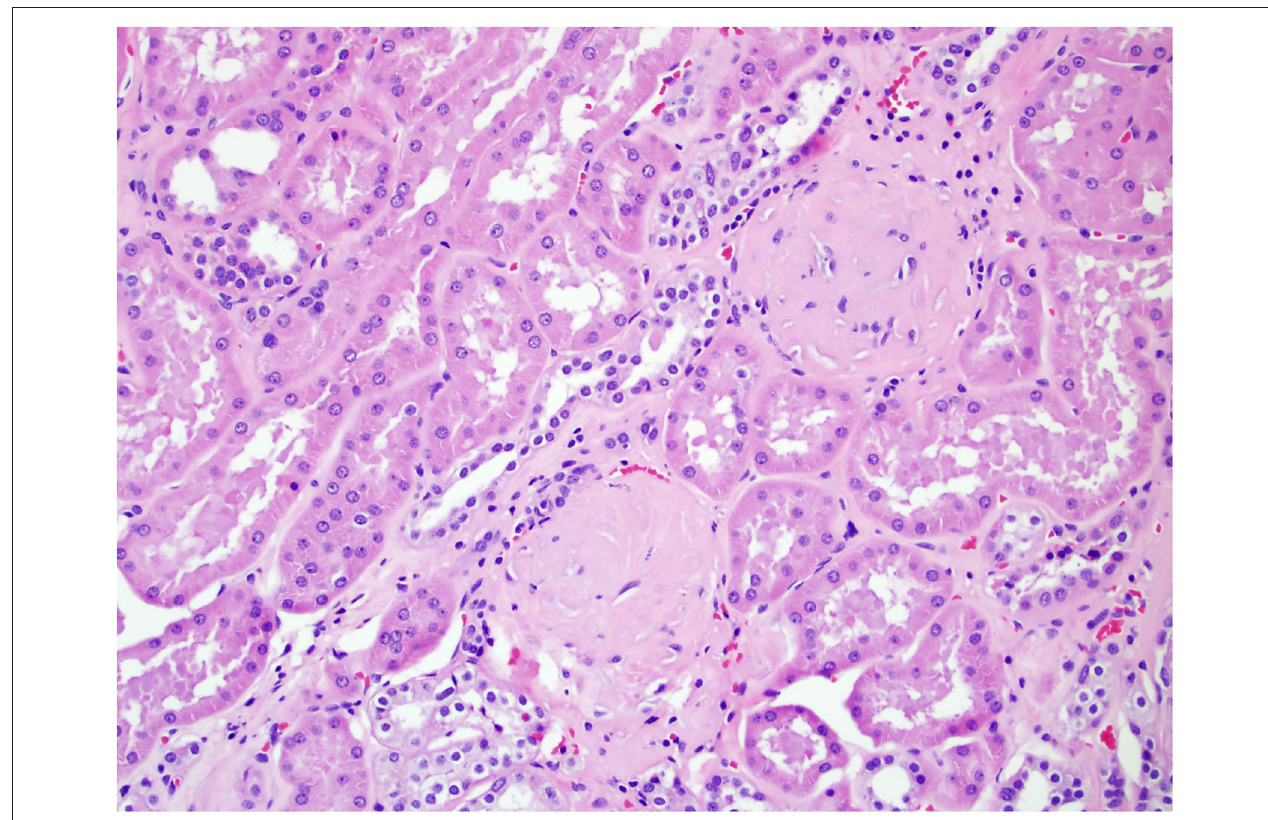
FIGURE 1 | Non-neoplastic renal tissue from a patient with GD on 200 × magnification. Two glomeruli were sclerotic, a typical histologic feature for glomeruli